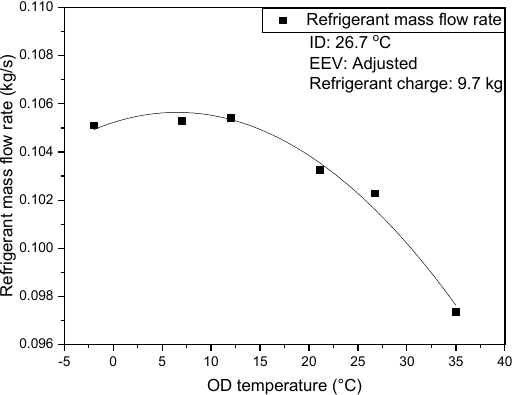
Figure 6. Saturation temperatures of conventional system according to OD air temperature.